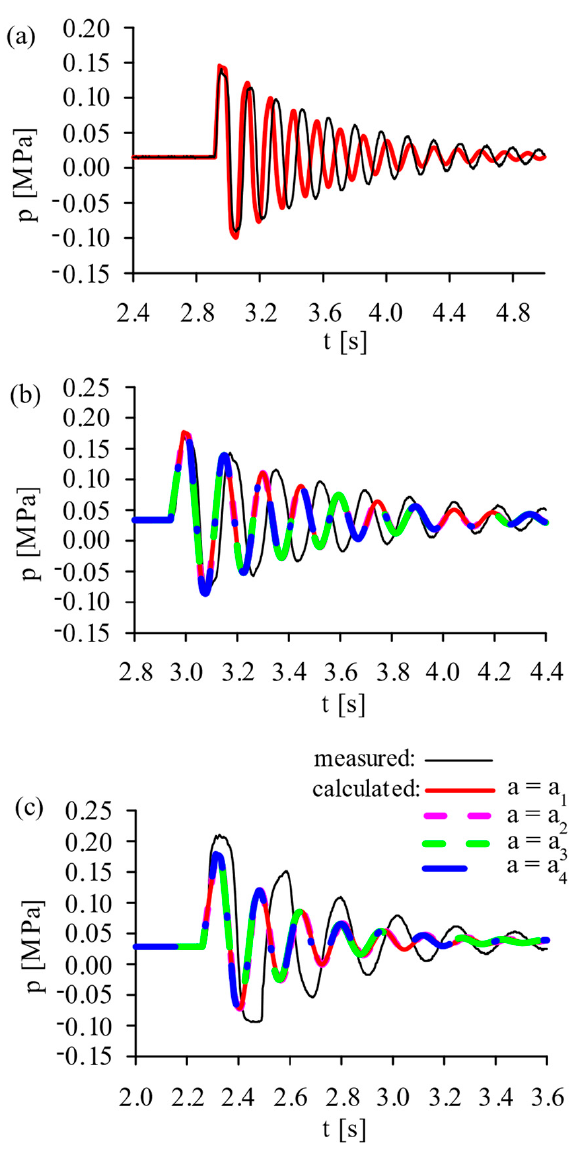
Figure 5. Pressure characteristics: measured (black line) and calculated with different theoretical values of wave celerity: ( a ) water; ( b ) slurry, C V = 0.007; ( c ) slurry, C V = 0.039.